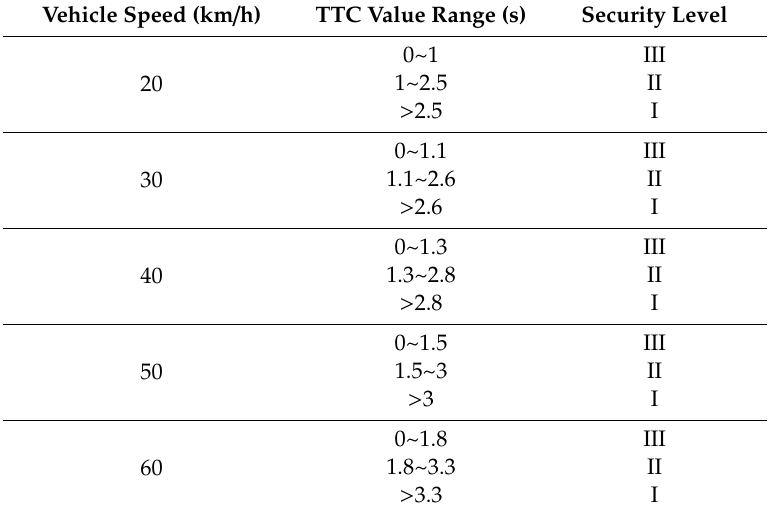
Table 2. The safety rating and TTC (time to collision) range under di ff erent working conditions. Vehicle Speed (km /